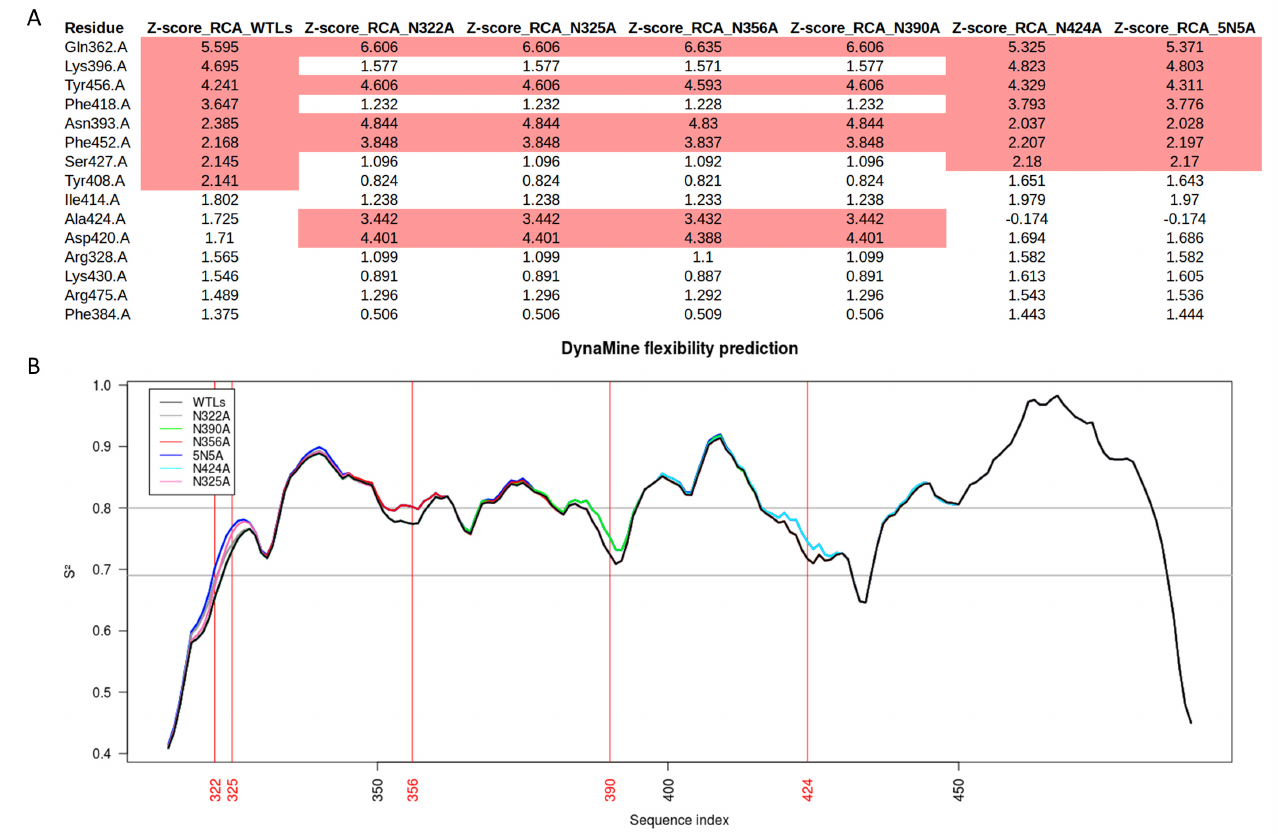
Figure 2. Residue Centrality Analyses (RCAs) of the TPR domain of the human O-GlcNAc transferase (PDB ID 4GYW). ( A ) Final result table showing the wild type TPR domain of the human OGT and the 6 mutants N322A, N325A, N342A, N356A, N390A and 5N5A (containing all five mutations), sorted by descending order of Z-scores of the wild type; Z-scores considered as relevant (Z-score ≥ 2) have a pink background; only the first 15 residues are shown. ( B ) DynaMine flexibility graphs of the wild type (WTLs) and each of the mutants; X=sequence index, Y=S², the higher S² value, the more rigid the backbone is predicted to be; grey horizontal straight lines delimit a context dependent zone; mutated residues are highlighted with red vertical straight